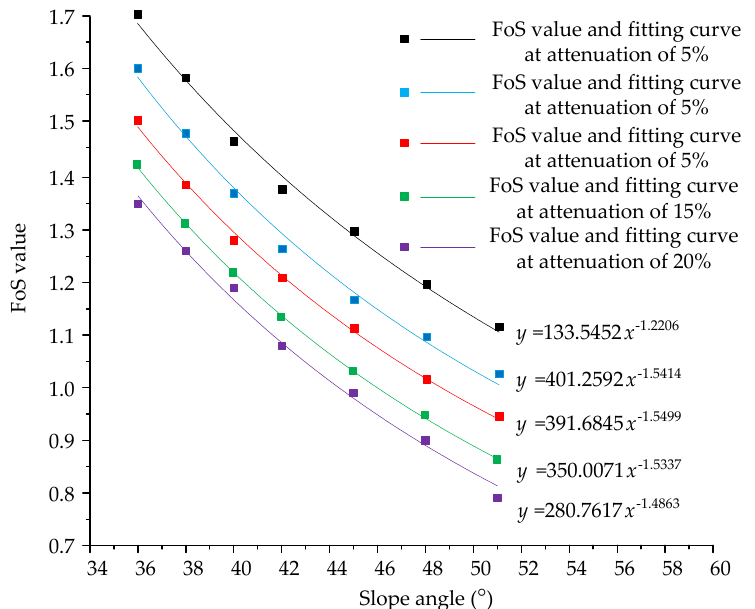
Figure 11. Fitting curves of slope angle and safety factors when aging parameters deteriorate by 5%, 10%, 15%, 20%, and 0%.